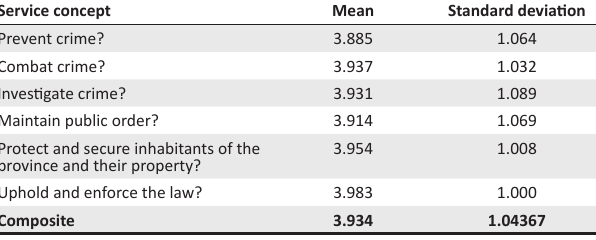
TABLE 3: Summary statistics of service concept. Service concept